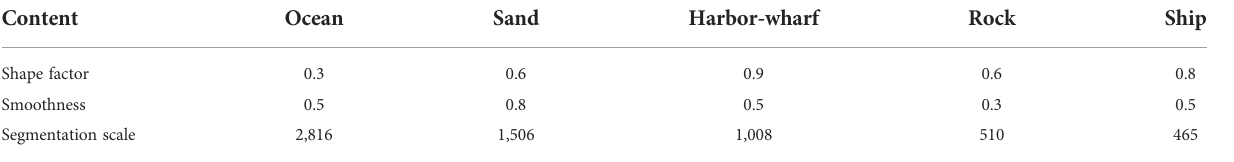
TABLE 4 Segmentation parameters of each coastal land